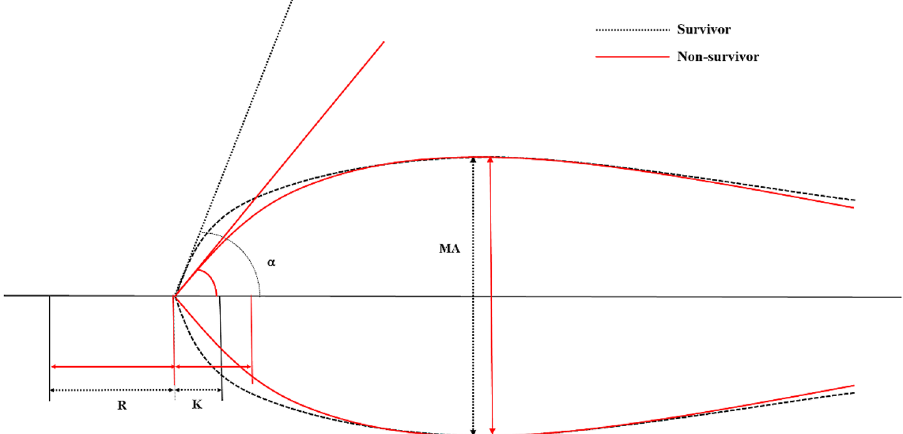
Table 3. Comparison of the TEG parameters in each group. Values are expressed as the median [interquartile range] or number (%). AUC area under the curve; TEG thromboelastography.